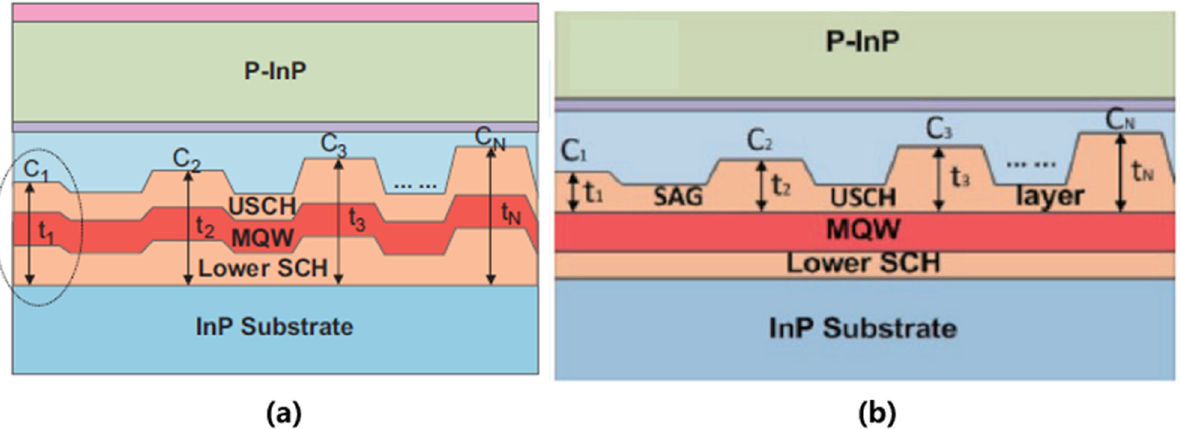
Figure 25. ( a ) Schematic of the MWLA structure achieved via conventional SAE. The upper and lower SCH and MQW were thicker due to the growth-rate enhancement generated by the masks.